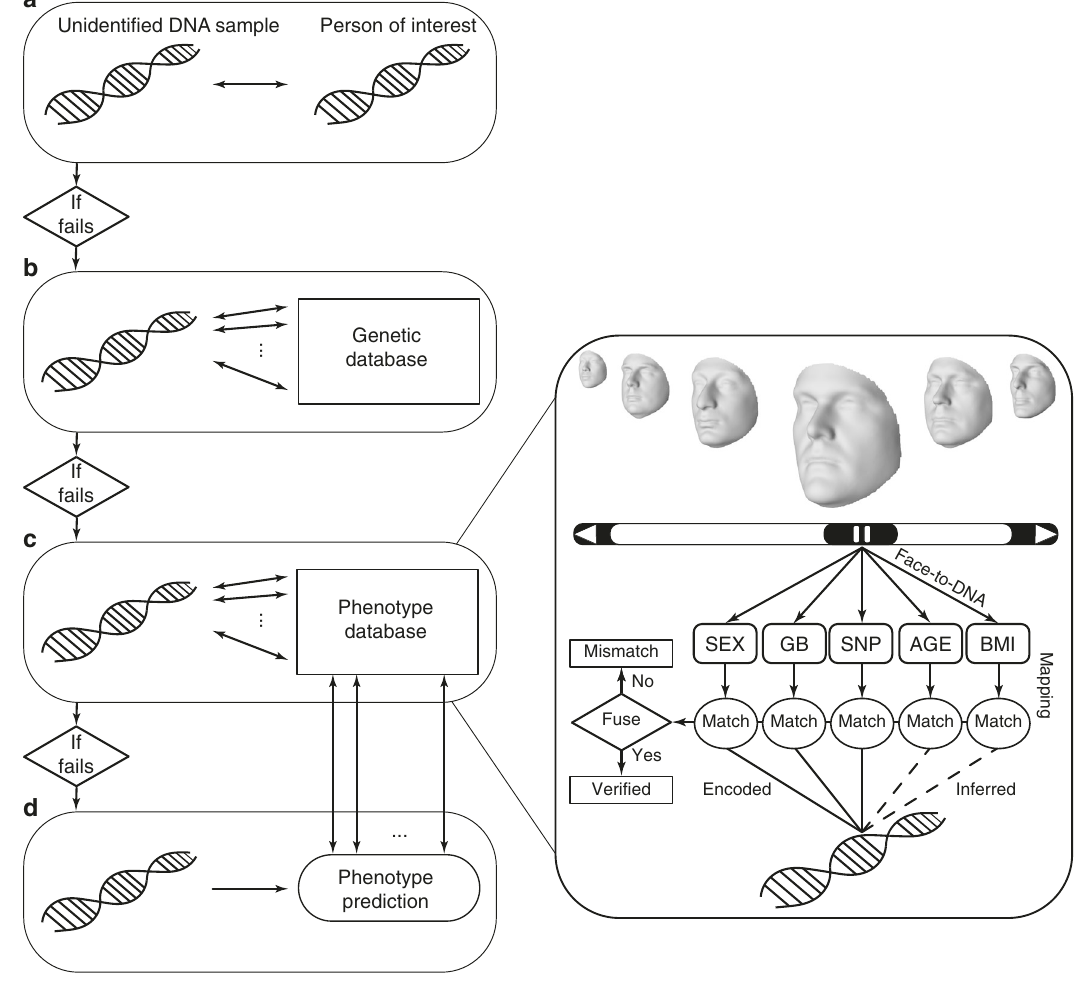
Fig. 1 Flowchart representing the proposed paradigm in the context of existing DNA investigative tools. a Given an unidenti fi ed DNA sample, the fi rst attempt is to match it to the DNA of a person of interest. b If the matching fails, then the same unidenti fi ed DNA sample is matched against DNA pro fi les of persons with known identity enrolled in the genetic database. c Our method could be of help if identi fi cation fails again. Each face-to-DNA classi fi er matches a face, in a gallery of faces (phenotype database), in terms of molecular features including sex, genomic background (GB), individual genetic loci (SNP), age, and body mass index (BMI) to a single probe DNA. Multiple, one per aspect, matching scores are fused together to provide an overall score, based upon which, it becomes possible to verify or reject a DNA pro fi le against a face with known identity. d By using DNA phenotyping, predicted phenotypes could as well be matched against given phenotypes, but more likely lead to the last resort solution, namely showing it to the public and hoping that someone recognizes the individual. However, the current state of DNA phenotyping has not achieved this ability